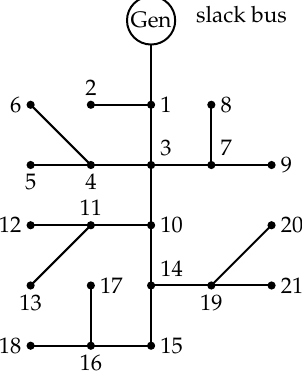
Figure 3. Electrical configuration for the 21-bus test system.